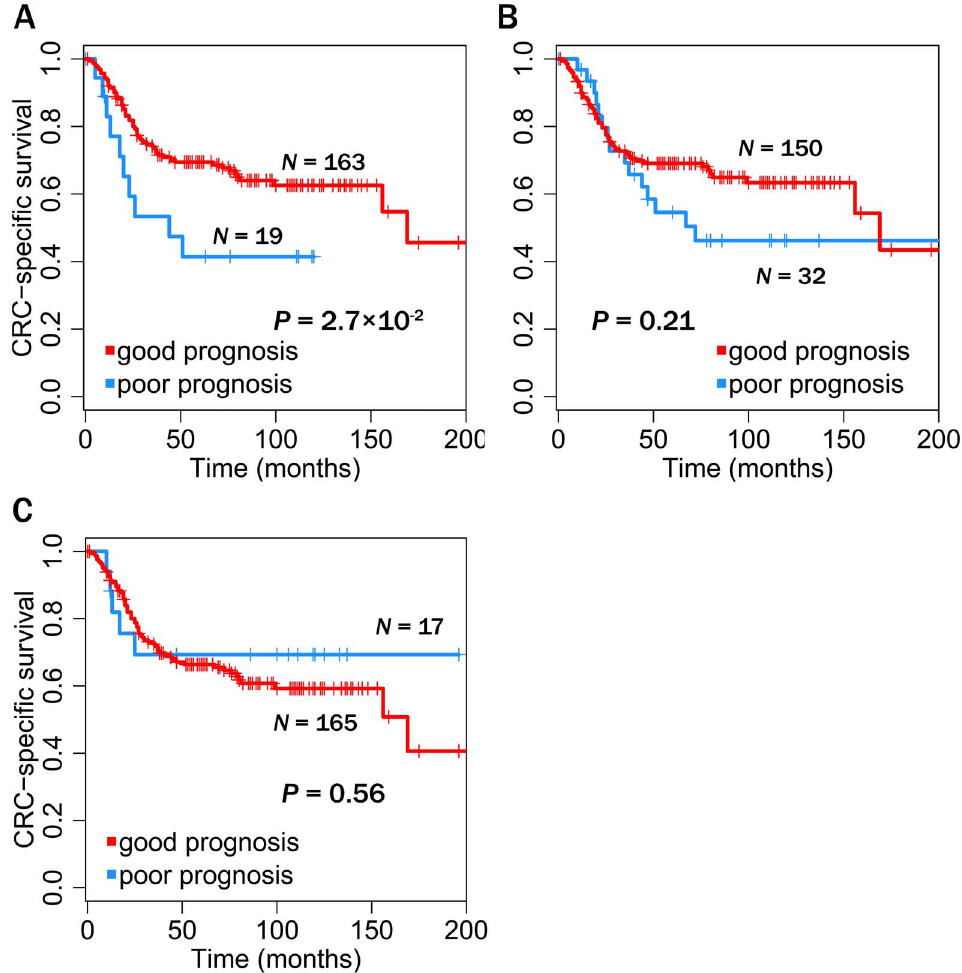
Figure 5. Identification of the prognostic reproducibility of markers. Their prognostic ability was examined in an independent test data [22] by supervised classifications and thus confirmed their prognostic reproducibility. ( A ) Prognostic ability of our bridge proteins ( B ) Prognostic ability determined by the ColoPrint gene set in reference [28] ( C ) Prognostic ability determined by the Wang et al. gene set in reference [27].